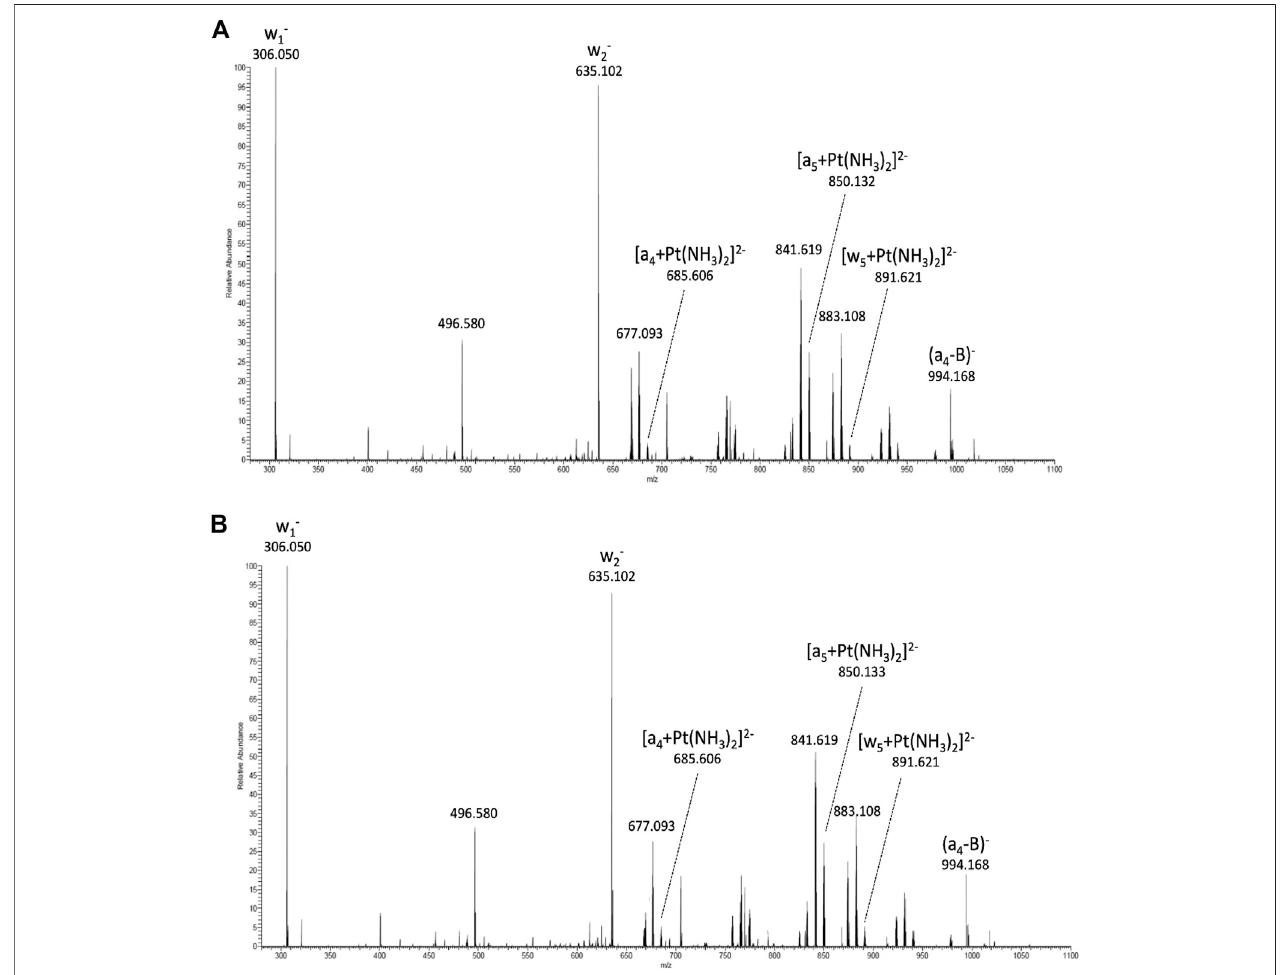
FIGURE 1 | MS/MS spectra obtained by collision-induced dissociation of the triply charged platinated hexadeoxynucleotide precursor ions (m/z 669), which basicallyshowtheidenticalfragmentionsandgiveevidenceforadductformation( (cid:2) unchangeddrugactivity).AdductformationandDNAbindingsitesbynaïveCisplatin (A) Cisplatin after electrospray (B) .